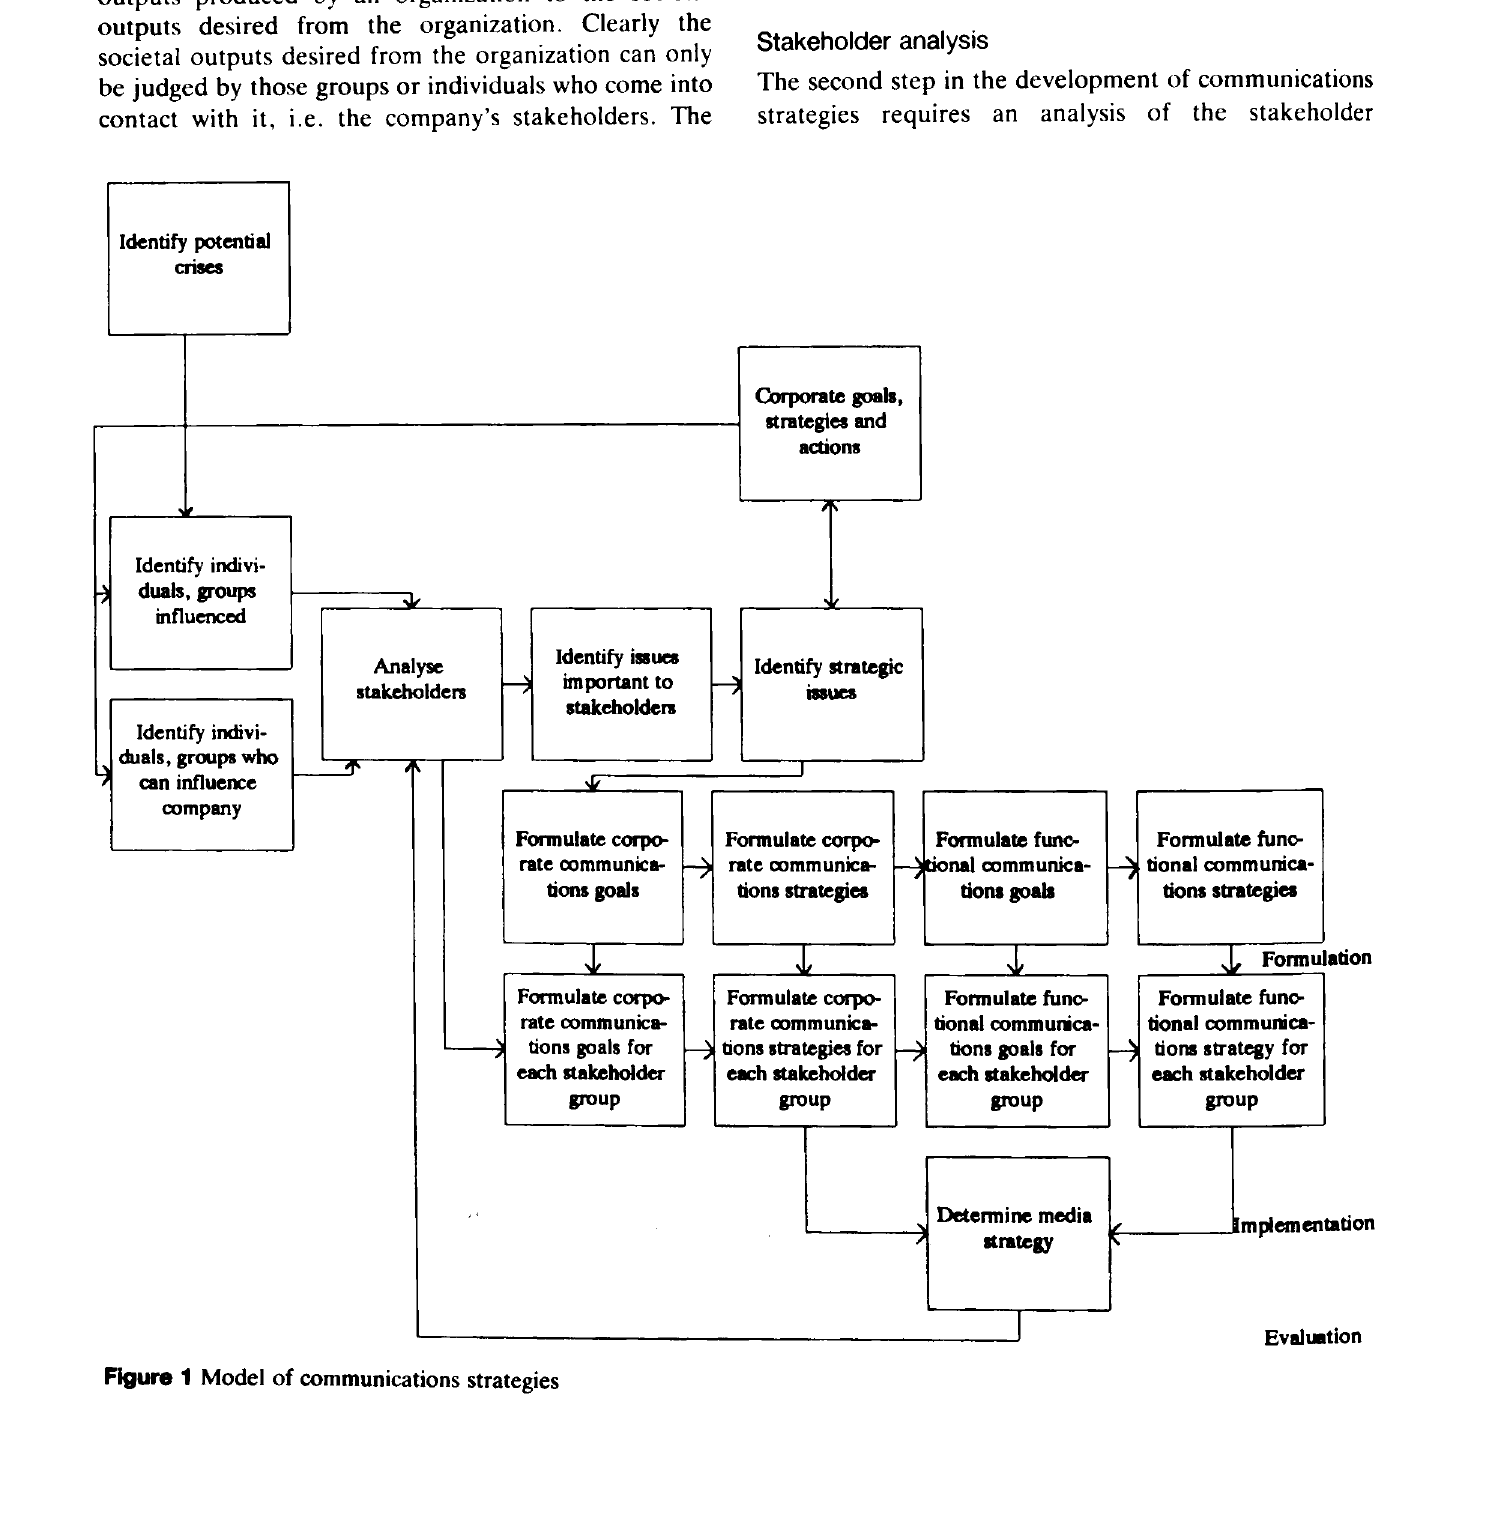
Figure 1 Model of communications